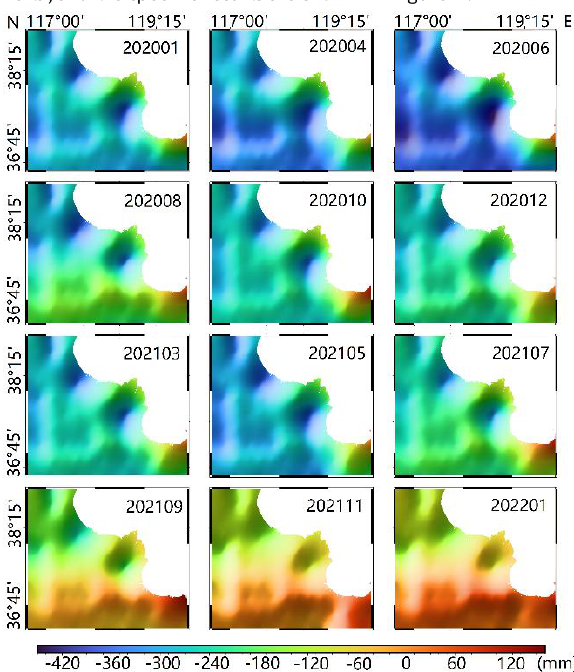
Figure 6. Cumulative changes in groundwater time series from